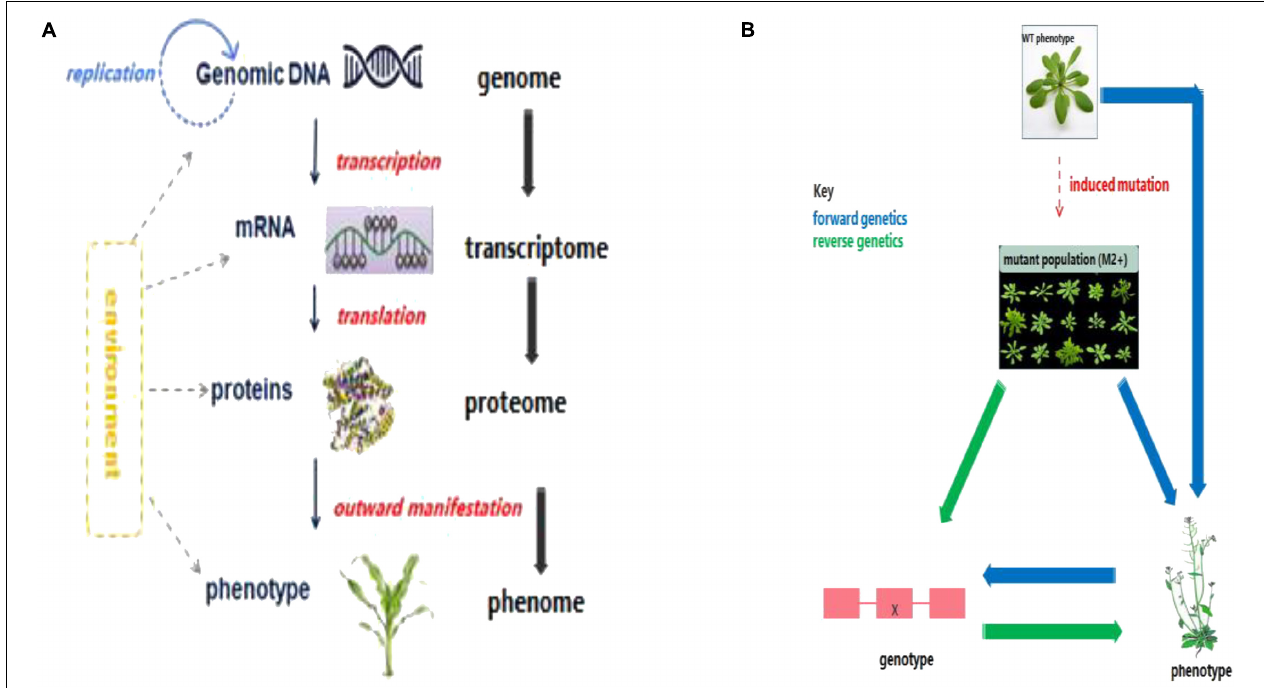
FIGURE 1 | Link among the major biological molecules and genetic approaches for crop improvement. (A) A cascade of interactions among the major biological molecules constituting the central dogma of molecular biology. Owing to the complexity of biological systems and molecular interactions, the simplistic arrows shown here offer only a general scheme of cascading influence. Dotted lines imply that the environment affects the biomolecules at different levels. (B) Genetic approaches for crop improvement. The canonical forward genetic approach involves creating variation (either naturally or via induced mutations) in a population; identifying interesting and novel phenotypes; and then cloning the gene/s responsible for the identified phenotypic variation. Reverse genetic approach involves first carrying out genotypic screening of the mutant population to identify novel induced mutations in candidate genes, and then perform phenotypic evaluation of those individuals harboring putative mutations (Jankowicz-Cieslak and Till, 2015; SETAC,